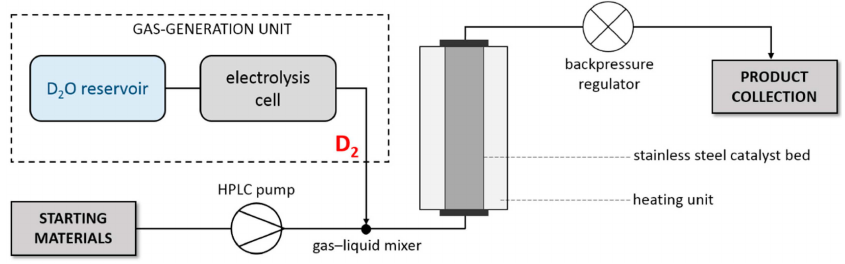
Figure 3. Schematic outline of the continuous-flow deuteration reactor (H-Cube ®